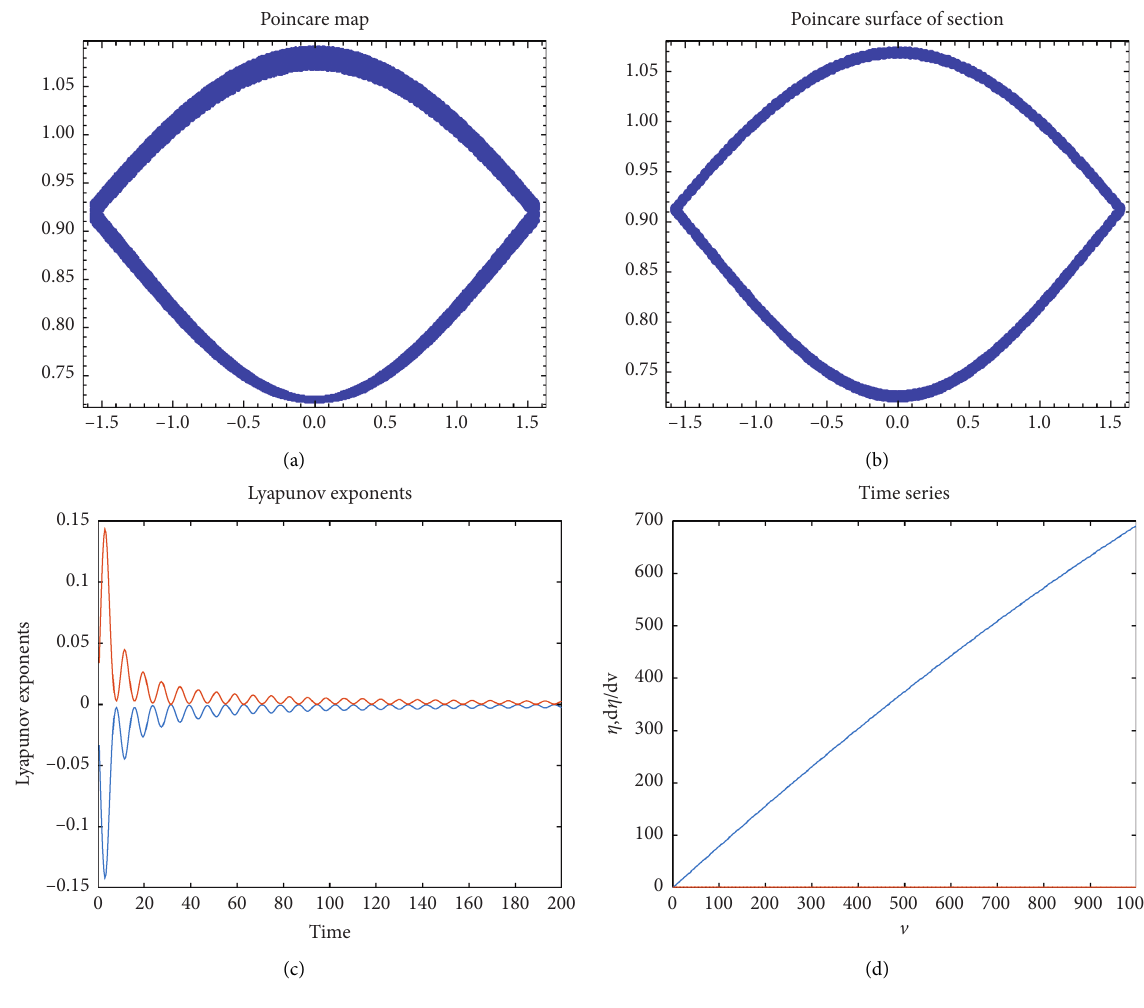
8: For n � 0 . 4 , ε � 0 . 000000000000000000005 , A E � 200 . 1022 , and e � 0 . 001. (a) Poincare map, (b) Poincare surface of section, (c) Lyapunov exponent, and (d) time ∗